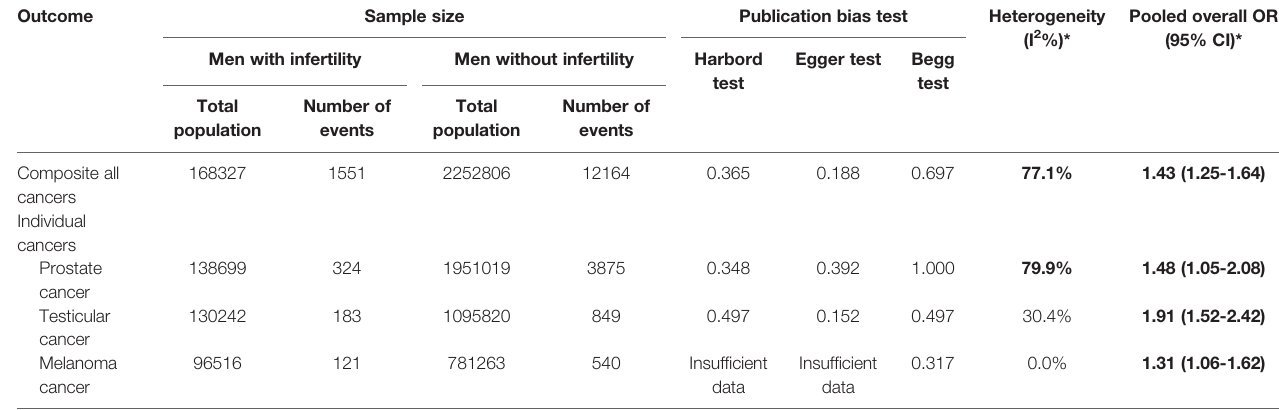
TABLE 2 | Results of heterogeneity estimation and publication bias assessment, and meta-analysis for the risk of cancer among men with infertility compared to men without